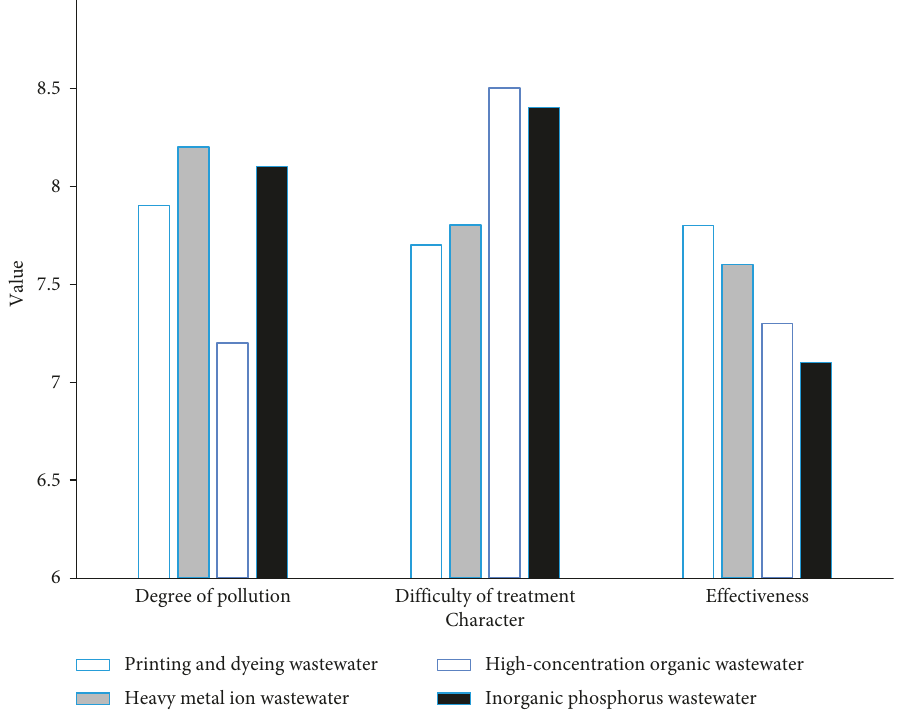
Figure 3: Sewage treatment index of different types of factories. Table 2: Chemical composition of fly ash.